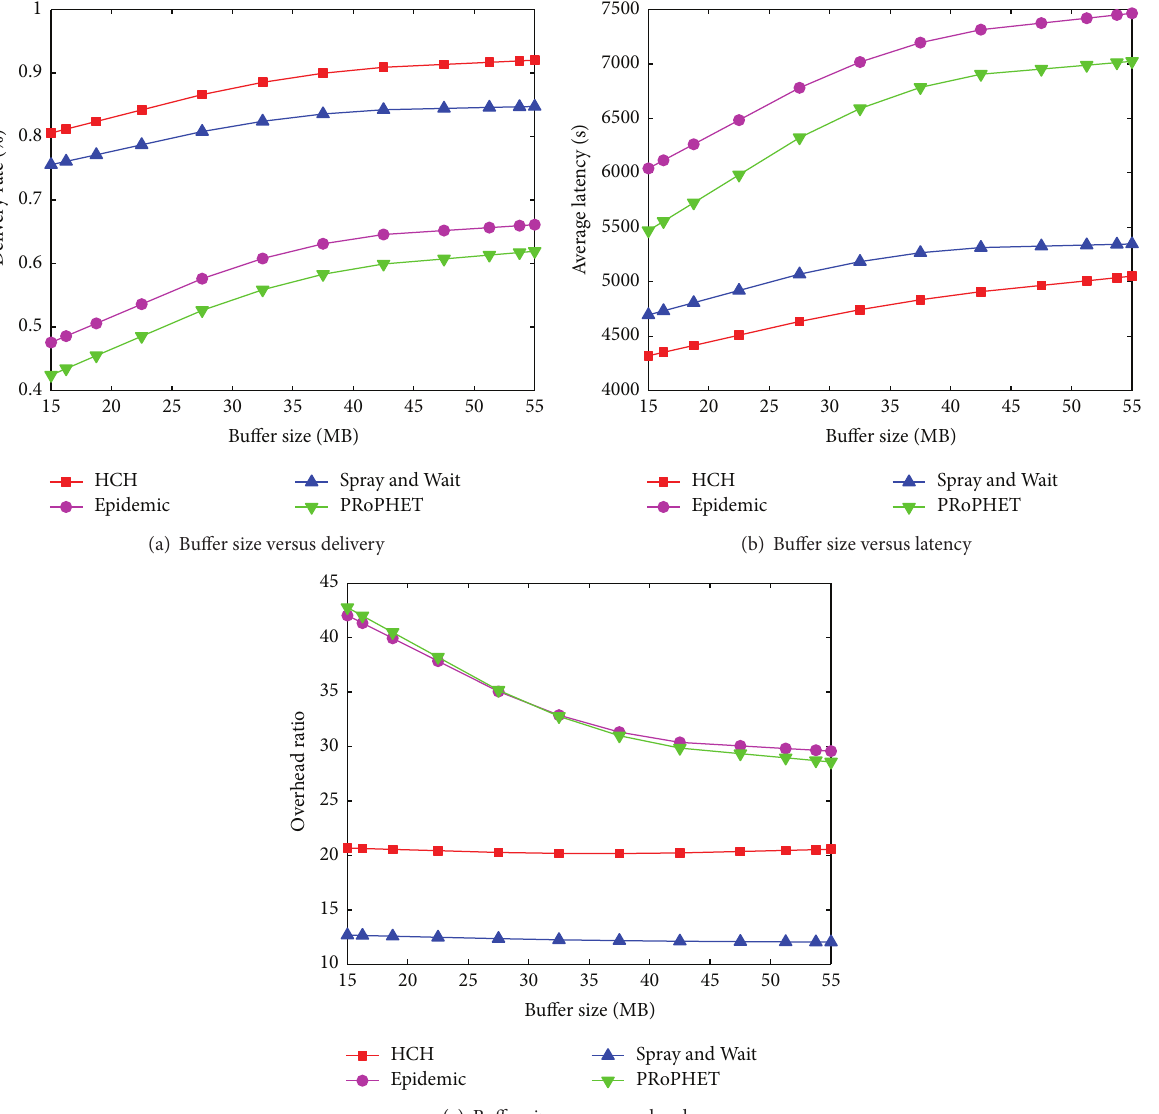
Figure 5: [Helsinki City Scenario] Buffer size versus delivery ratio, average latency, and overhead